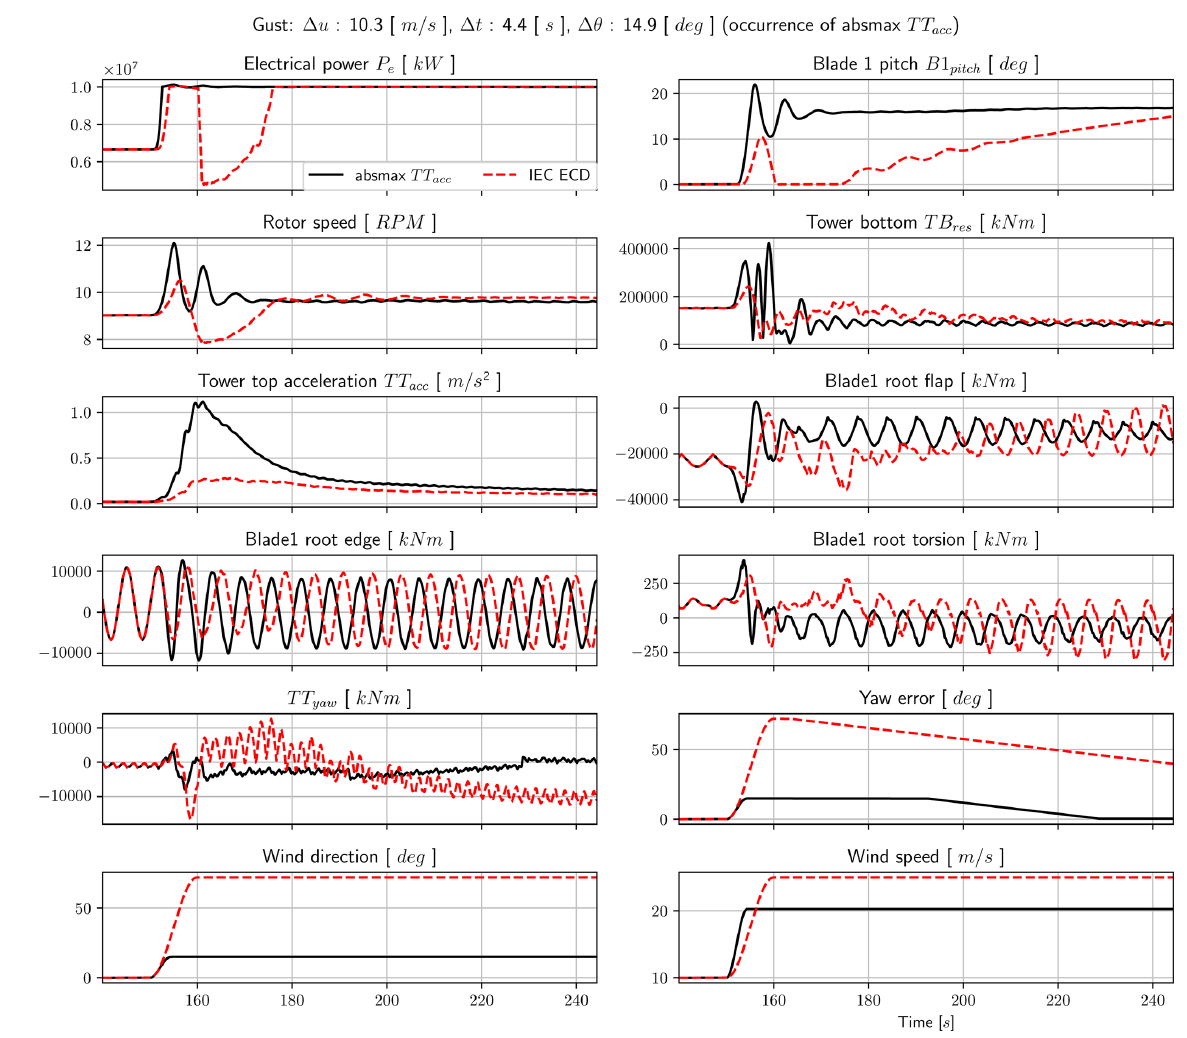
Figure A1. Gust for which the tower-bottom resultant bending moment TB res and the tower-top acceleration TT acc have the absolute maximum (see also Table 2). Note that the label is only shown in the upper-left panel (solid line for the gust case as indicated in the panel title and dotted line for the IEC ECD